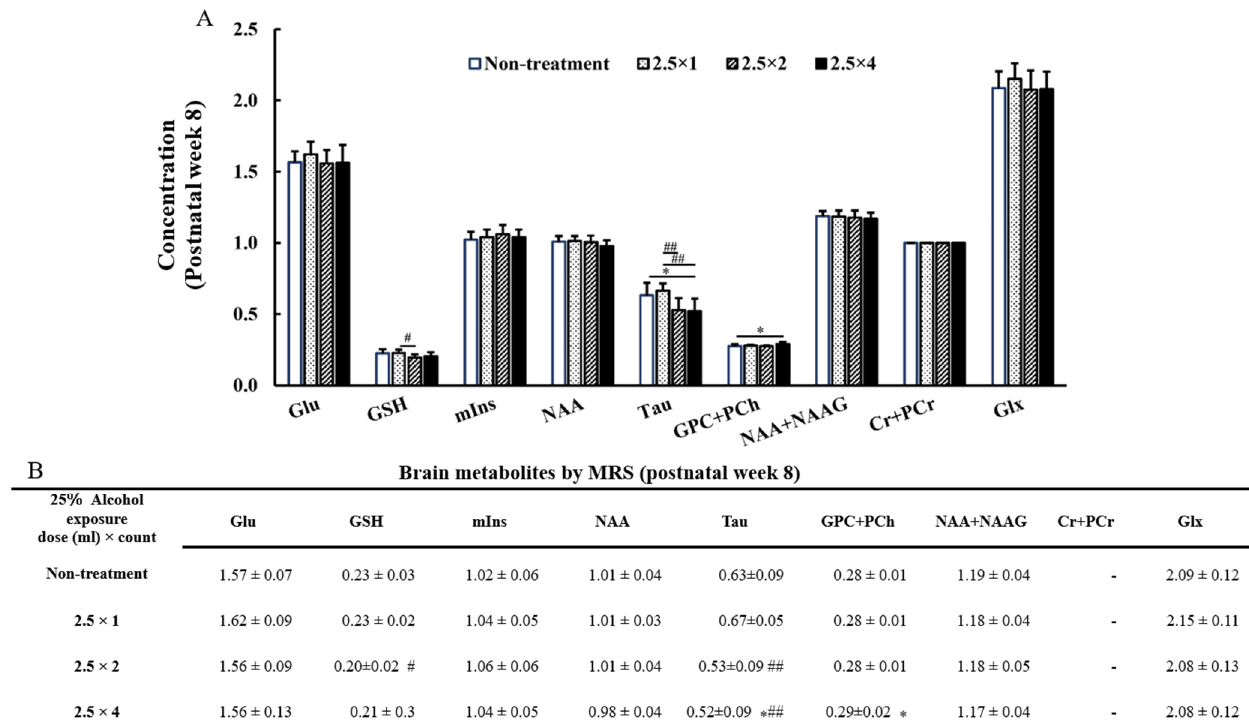
Figure 7. Graph ( A ) and Table ( B ) of brain metabolites on MRS at 8 weeks of age: glutamine (Glu), glutathione (GSH), Myo-inositol (mIns), N-acetyl aspartate (NAA), taurine (Tau), glycerophosphocholine + phosphocholine (GPC + PCh), N-acetyl aspartate + N-acetyl aspartyl glutamate (NAA + NAAG), creatine + phosphocreatine (Cr + PCr), and glutamine + glutamic acid (Glu + Gln). The results of the comparison between the four-groups (non-treatment, 2.5 × 1, 2.5 × 2, and 2.5 × 4) are shown. Between-group comparisons were analyzed by one-way ANOVA with Tukey’s multiple comparison tests using Prism 9. The results showed no signi fi cant di ff erence between the two-dose group (2.5 × 2) and the four-dose group (2.5 × 4). When compared with the non-treatment: * p < 0.05. When compared with the one-dose FASD group (2.5 × 1): # p < 0.05; ## p < 0.01.